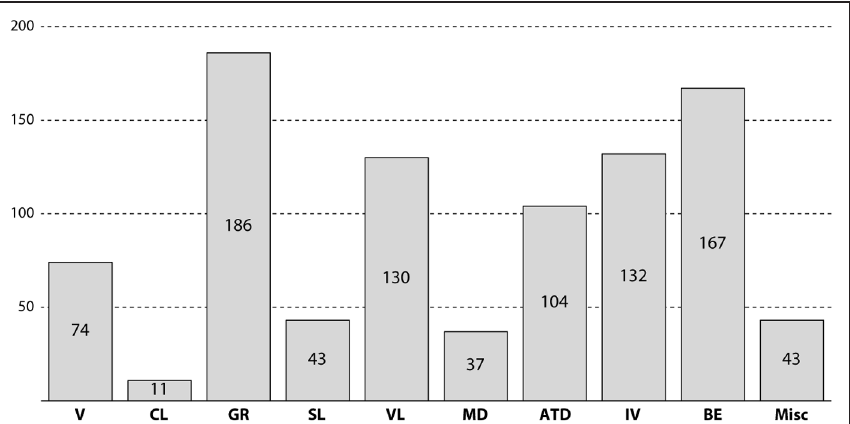
Figure 1: Total number of musical references in each book, ordered by publication date. Henceforth: V: V. ; CL: The Crying of Lot 49 ; GR: Gravity’s Rainbow ; SL: Slow Learner ; VL: Vineland ; MD: Mason & Dixon ; ATD: Against the Day ; IV: Inherent Vice ; BE: Bleeding Edge ; Misc.: uncollected miscellaneous writings.